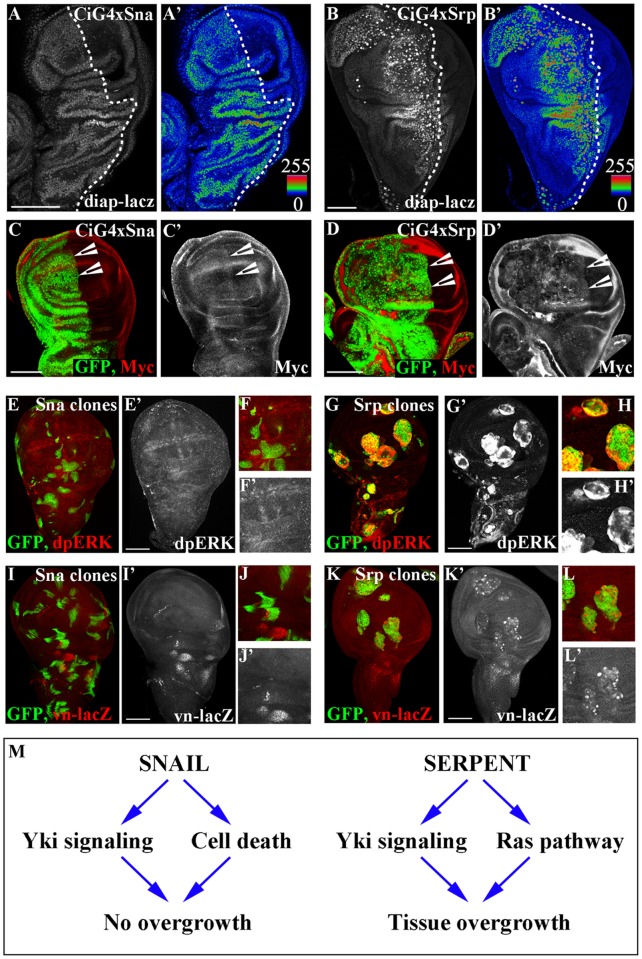
Srp activates both the Yki and Ras signalling pathways.A-D CiGal4, Gal80ts was used to drive either sna (A, C) or srp (B, D) expression in the anterior compartment of discs containing the diap-lacZ reporter (A, B) or in a wildtype background together with GFP (C, D). Discs are stained for lacZ (A, B) or for GFP (green) and Myc (red) (C, D). E-K Clones of either UAS-sna (E, F, I, J) or UAS-srp (G, H, K, L) generated in either a wild type (E-H) or a vn-LacZ reporter background (I-L). Clones were induced by a 30 min heat shock and fixed after 48 hours. Staining for dpERK shows that Ras signalling is activated downstream of Srp (G, H), but not downstream of Sna (E, F). Staining for LacZ showed that vn is upregulated at the transcriptional level by Srp (K, L), but not by Sna (I, J). Scale bars A-K—100μm. (M) Model showing the effects of ectopic activity of Sna and Srp in the wing disc reported in this work (additional targets are likely to be triggered as well); Sna represses crumbs, which in turn activates Yki signalling; Srp represses crumbs, activating Yki signalling and also activates vein, which activates the RAS pathway via the EGFR.